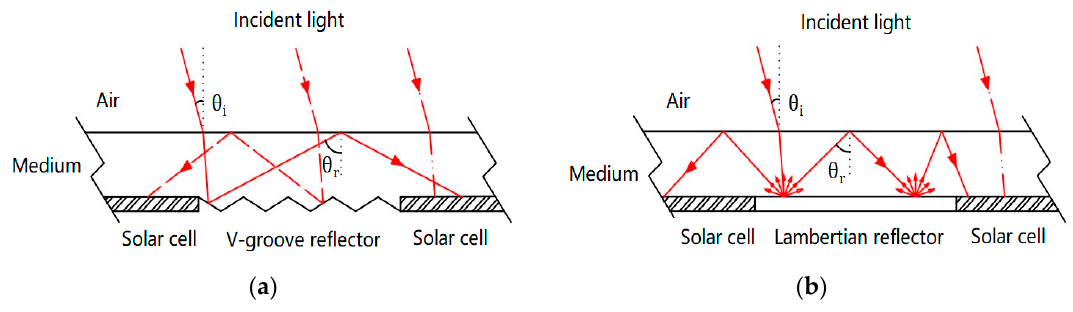
Figure 1. Light propagation within ( a ) a v-groove reflector based Photovoltaics (PV) concentrator and ( b ) a Lambertian reflector-based PV concentrator.